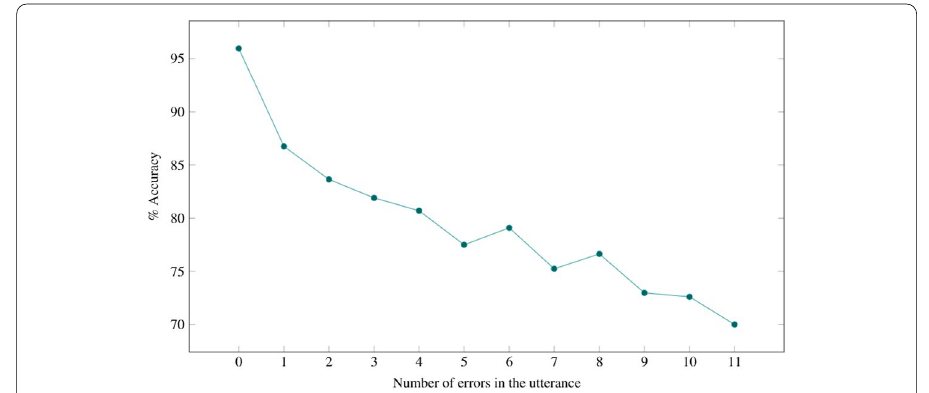
Fig. 6 General classification accuracy by number of error in the utterance on the test